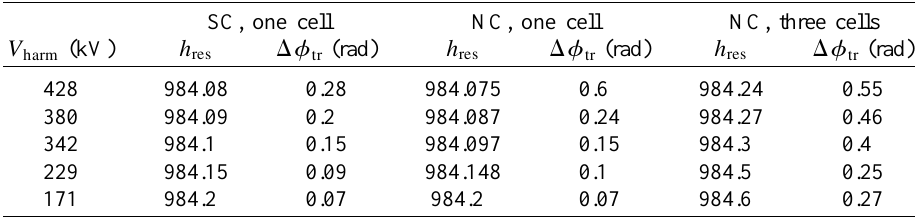
TABLE II. Comparison of transients from passive normal conducting and superconducting cavities. SC, one cell NC, one cell NC, three